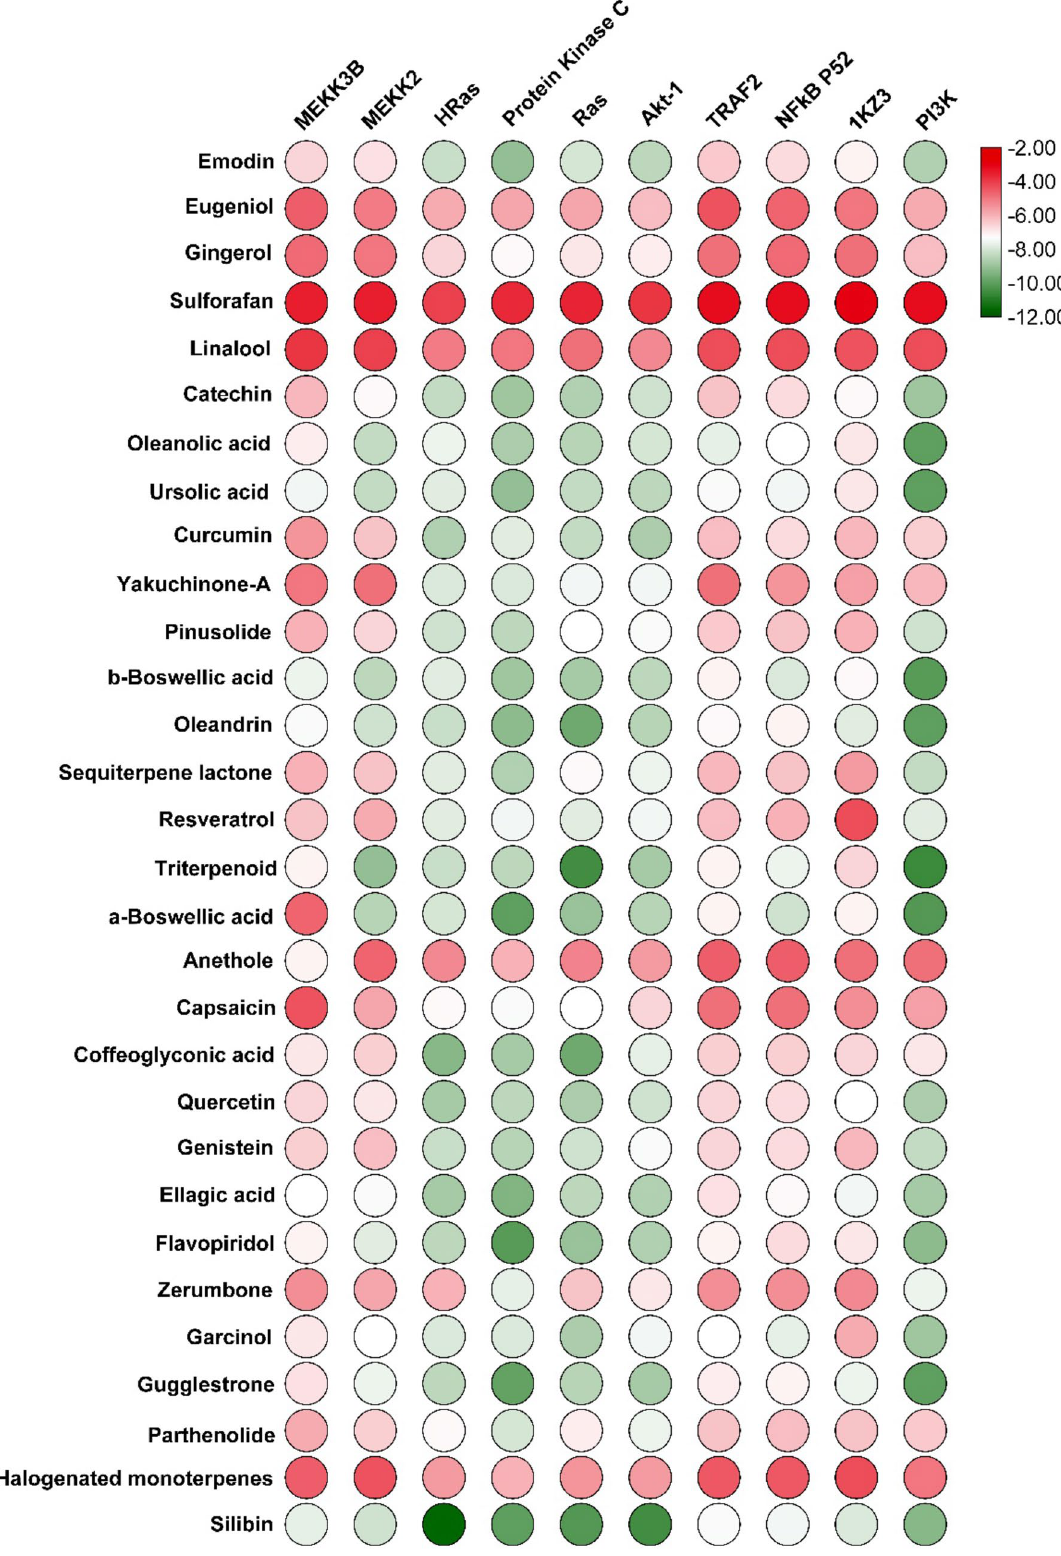
Figure 1. The heatmap represents the binding energies (kcal/mol) of the dietary compounds docked with various cancer